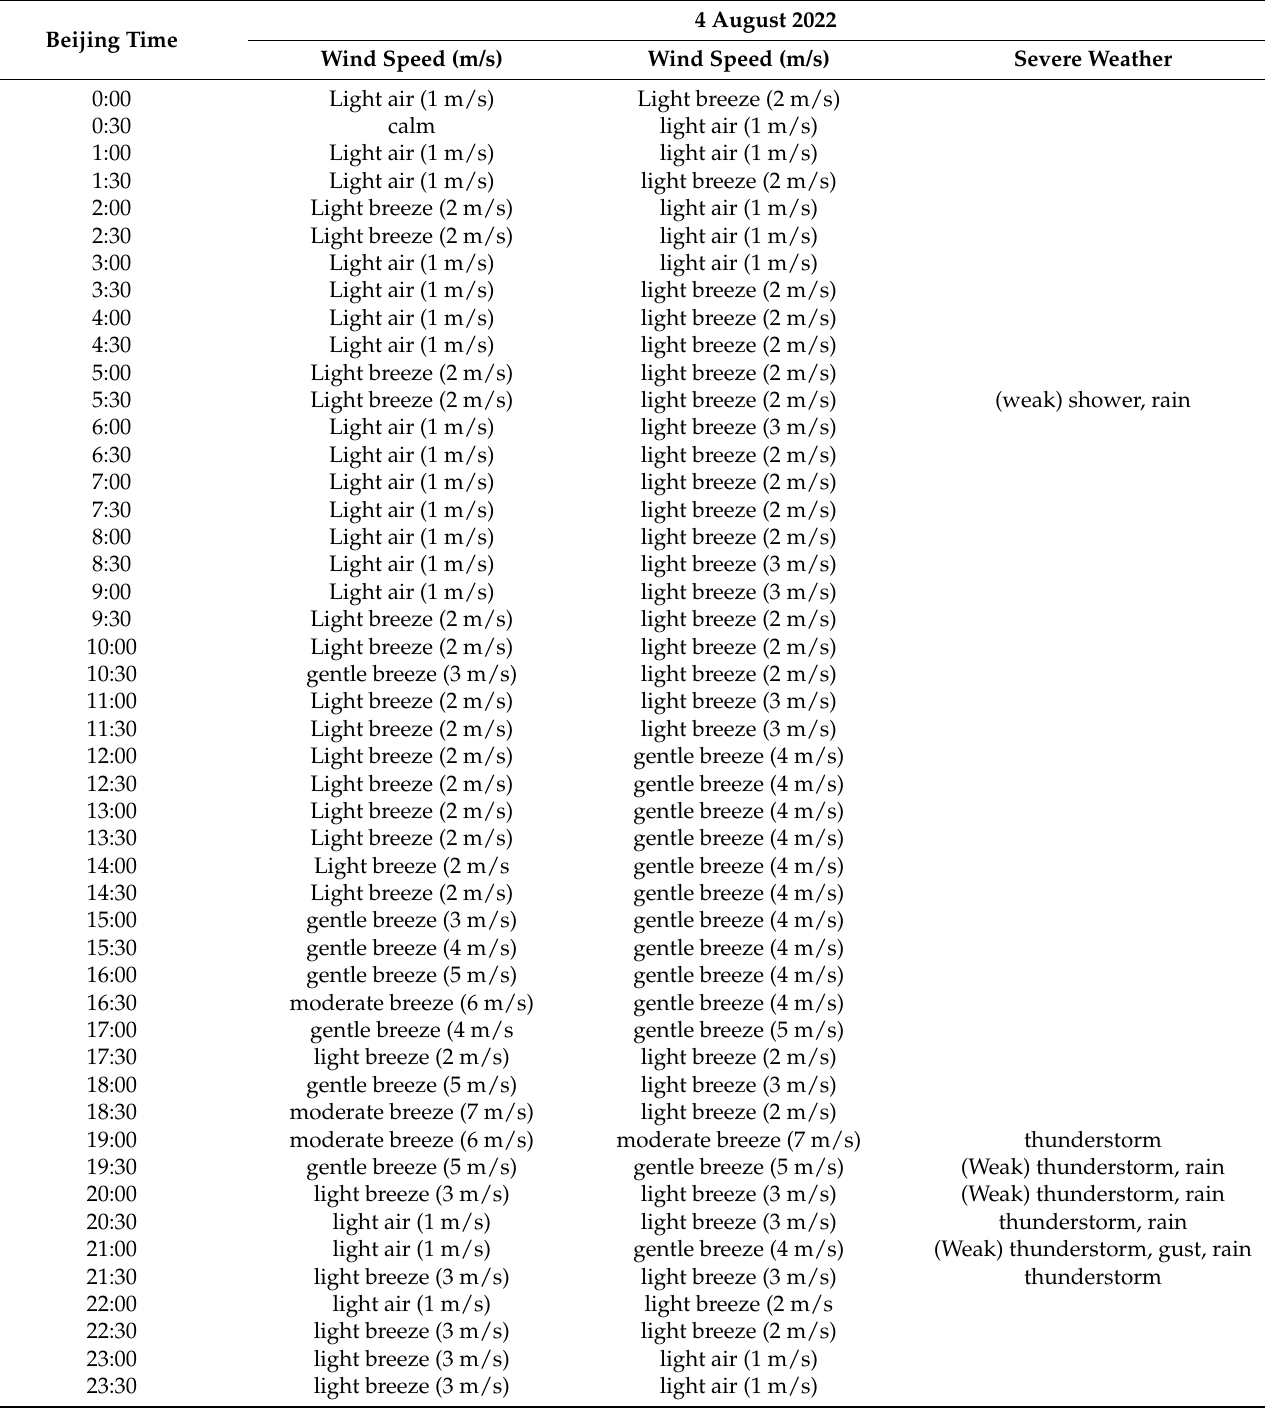
Table 3. The weather conditions for 4 August 2022 in Huairou, Beijing. 4 August